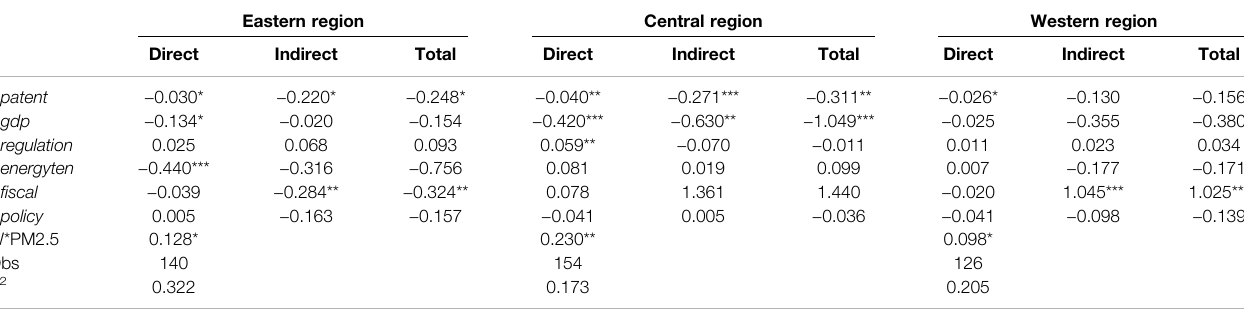
TABLE 10 | Regression results in different